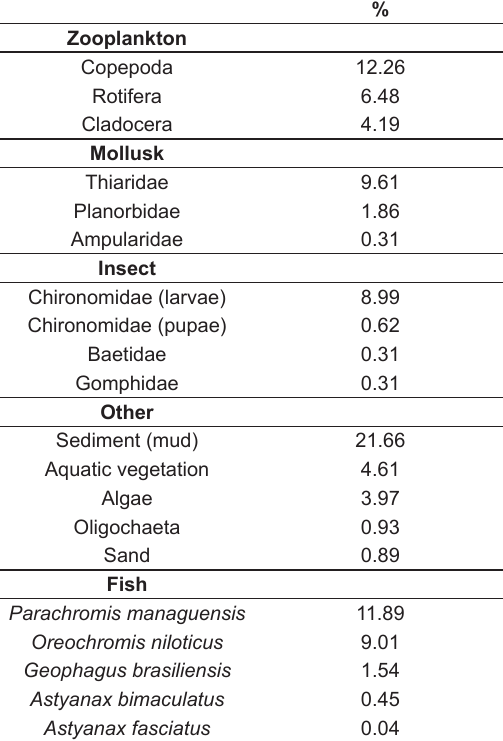
Table 3. Natural abundance (%) of possible food items measured during the study